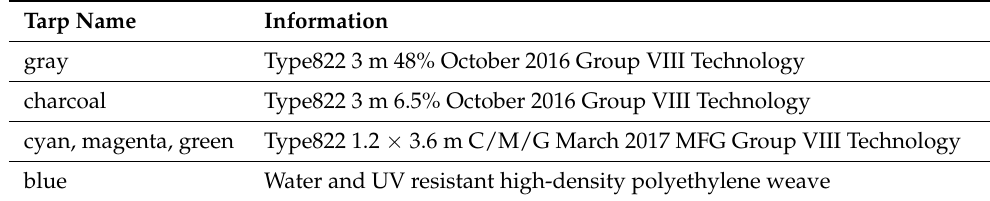
Table 3. Calibration tarp